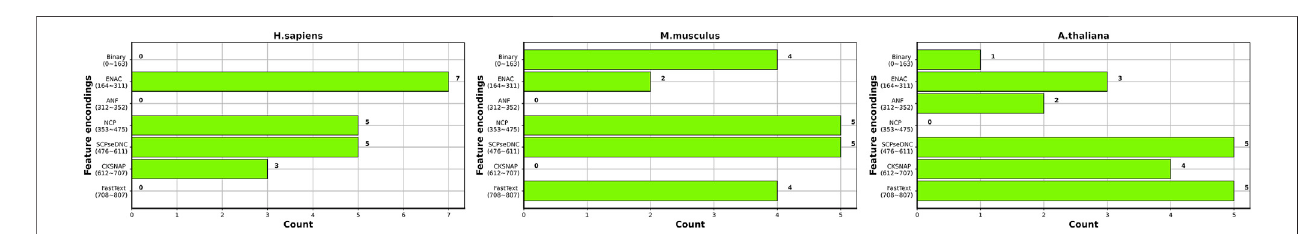
FIGURE 5 | Distribution of top 20 features in the seven types of features for the three